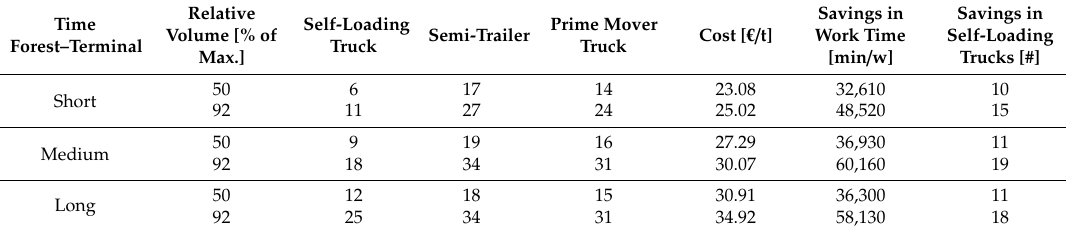
Table 5. Cost-optimal fleet configuration with the gross vehicle weight of a self-loading truck of 44 t and potential savings of the terminal concept in terms of work time and the number of self-loading trucks used in comparison to unimodal truck transport.